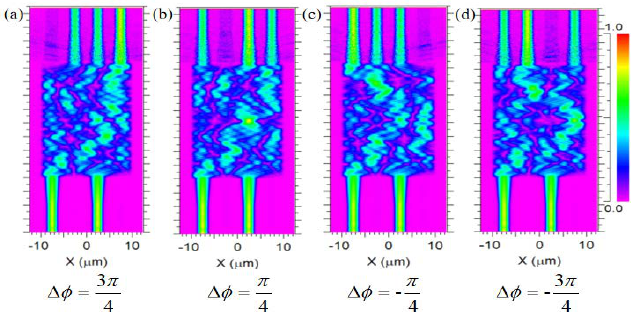
Figure 2. The field distribution of the 90° hybrid for two input ports with different phase differences.